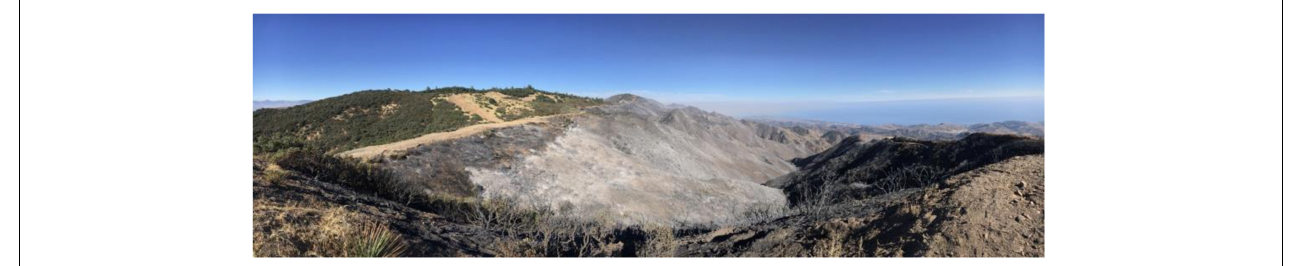
FIGURE 1 | Example of a traditional ridgetop fuel break. Such vegetation treatments are typically located to protect a specific resource and are part of a larger network of fuel breaks. (Credit: Rob Hazard).